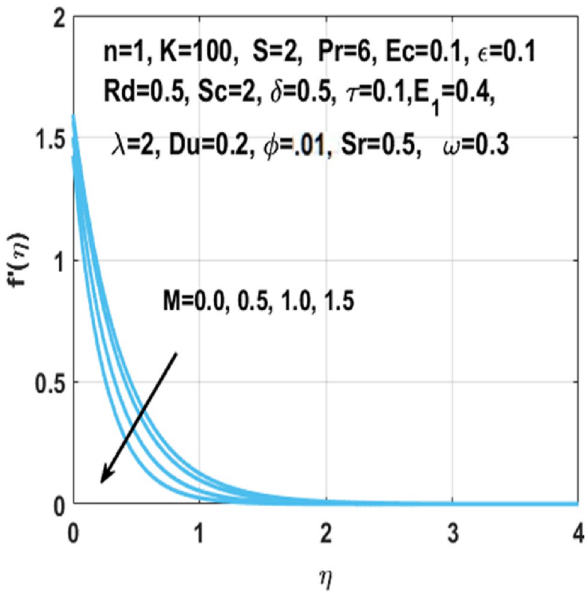
Figure 3. Impact of M on f ′ (η)